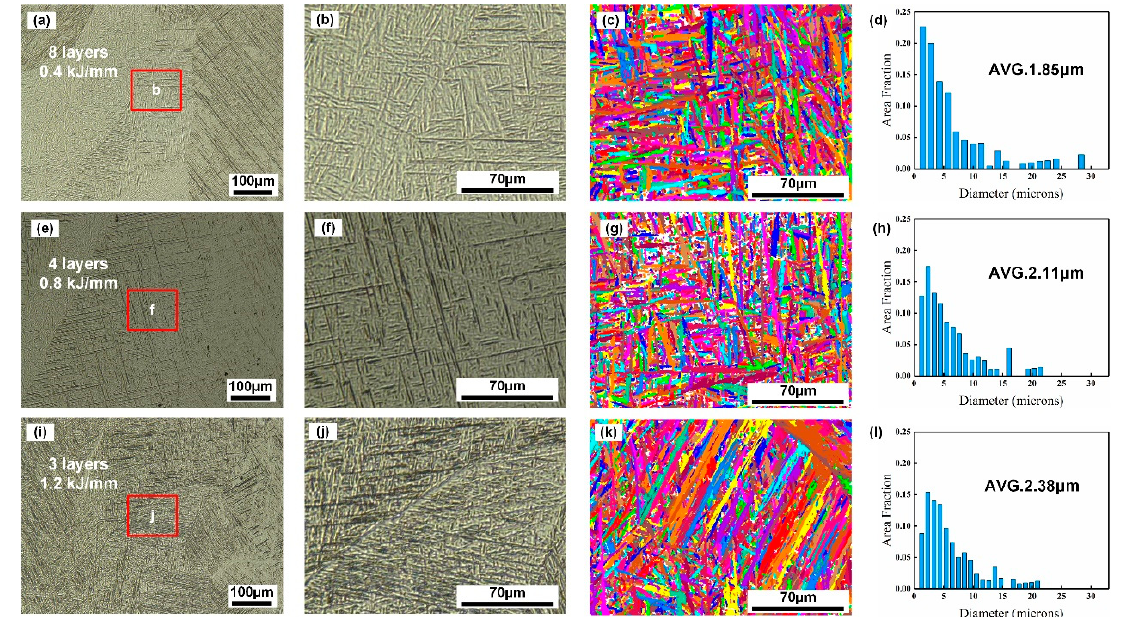
Figure 6. Microstructure and EBSD analysis results of different samples. ( a – d ) A total of 8 layers with 0.4 kJ/mm; ( e – h ) 4 layers with 0.8 kJ/mm; ( i – l ) 3 layers with 1.2 kJ/mm.